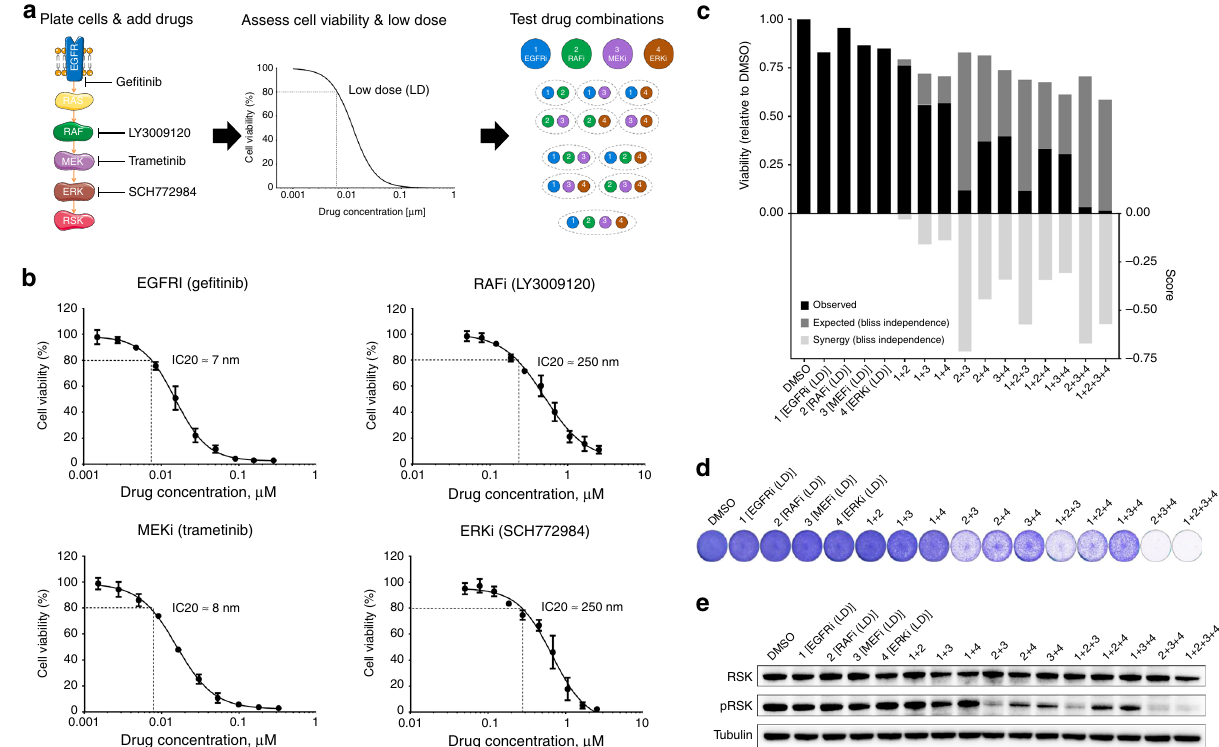
Fig. 1 Multiple low dose therapy blocks MAPK pathway and proliferation in PC9 cells. a Schematic of the Multiple Low Dose (MLD) ef fi cacy determination. After plating, cells are treated with increasing drug concentrations. Four days later cell viability is measured and the low dose (LD) is assessed. At last, the ef fi cacy of all the possible combinations at LD is determined. b Dose-response curves of EGFR, RAF, MEK and ERK inhibitors in PC9 cells. PC9 cells were cultured with increasing concentrations of EGFRi Ge fi tinib, RAFi LY3009120, MEKi Trametinib or ERKi SCH772984 for 4 days, after which cell viability was measured using CellTiter-Blue ® . Standard deviation (SD) from 3 biologically independent replicates (each with 3 technical replicates) is plotted. Low doses (IC20s) were then determined: ge fi tinib = 7 nM, LY3009120 = 250nM, 292 trametinib = 8 nM and SCH772984 = 250nM. c – e Determination of the ef fi cacy of all the possible combinations of EGFR, RAF, MEK and ERK inhibitors at LD in PC9 cells. PC9 cells were cultured with all possible drug combinations of EGFR, RAF, MEK and ERK inhibitors at the low doses determined in b . In c cell viability from 3 biologically independent replicates (each with at least 3 technical replicates) was measured by CellTiter-Blue ® assay after 4 days of treatment; In black the observed experimental viability; In dark-grey the expected viability and in light-grey the synergy scores, calculated using the Bliss independence model, are plotted. In d cells were treated for 10 days, after which plates were stained and scanned; A representative image from the 3 biologically independent replicates performed is displayed. In e protein for western blotting was harvested after 24 h of treatment; The level of pathway inhibition was determined by examining pRSK protein levels in the western blot. Tubulin was used as loading